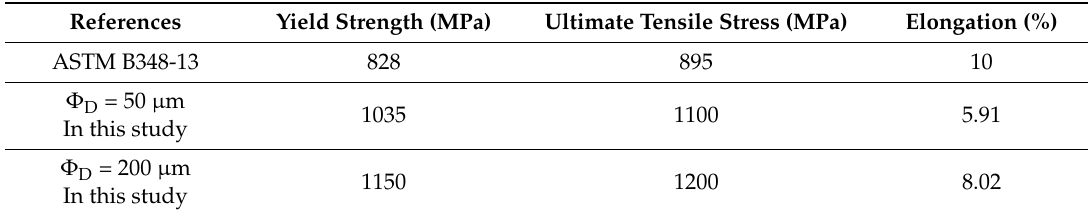
Table 2. Comparison of the mechanical